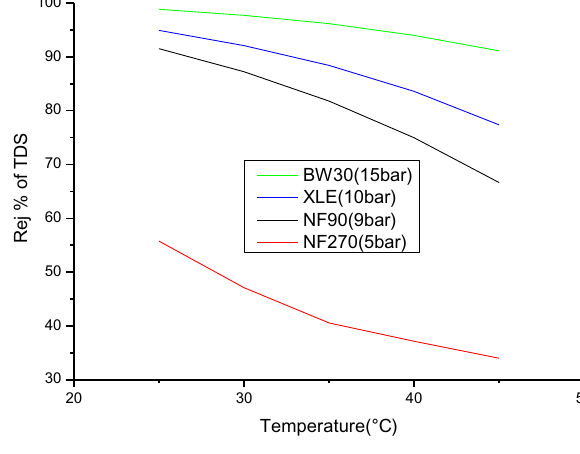
Fig. 9 Effect of temperature on TDS % removal at optimum feed pressure for conf